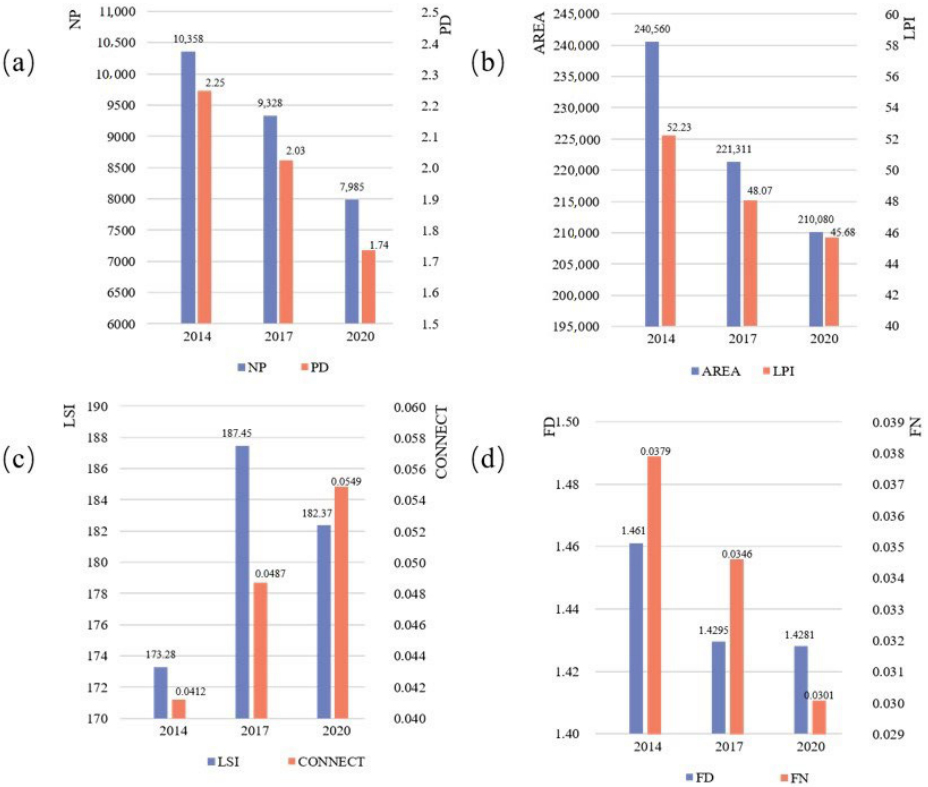
Figure 4. Landscape pattern evolution: ( a ) NP and PD; ( b ) maximum patch area and LPI; ( c ) LSI and CONNECT; and ( d ) FD and FN.